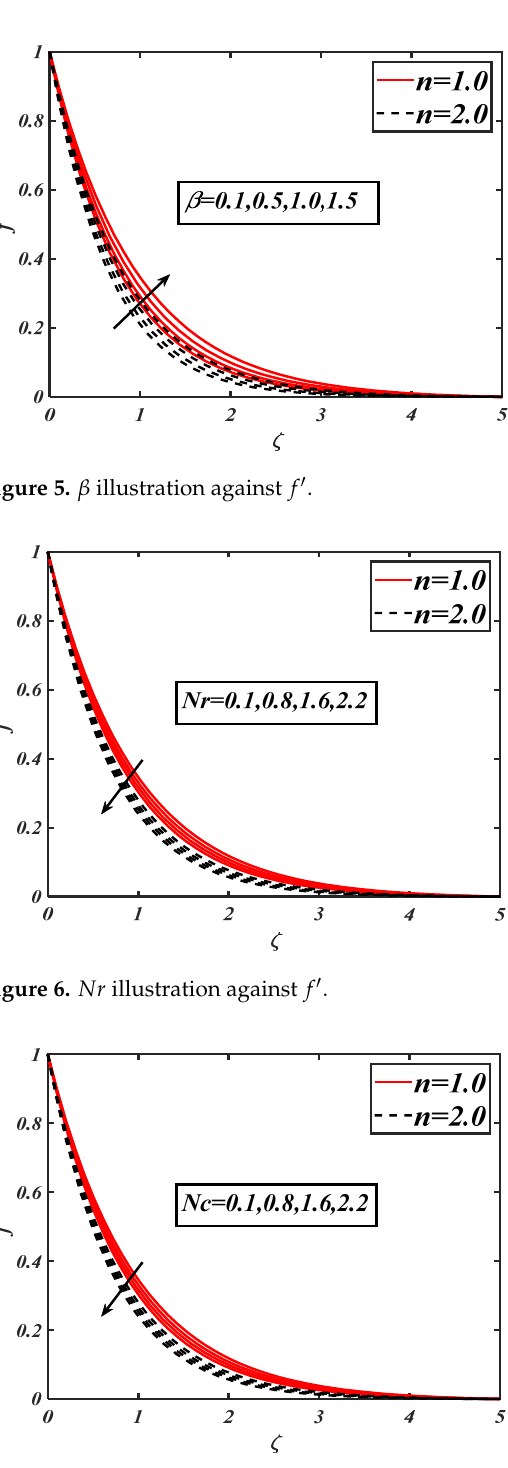
Figure 7. Nc illustration against f (cid:48)